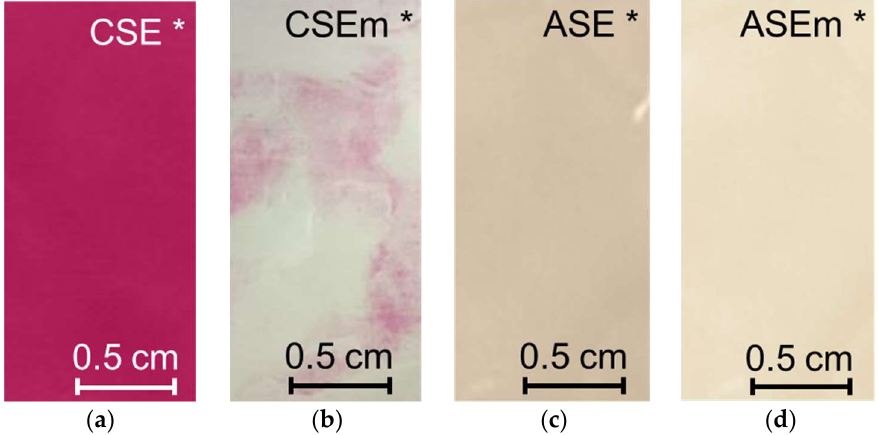
Figure 10. Optical images of the surfaces of CSE and ASE ( a , c ) and modified CSEm and ASEm ( b , d ) membranes facing the desalination compartment. The membranes after electrodialysis processing of the model solution are indicated by *.